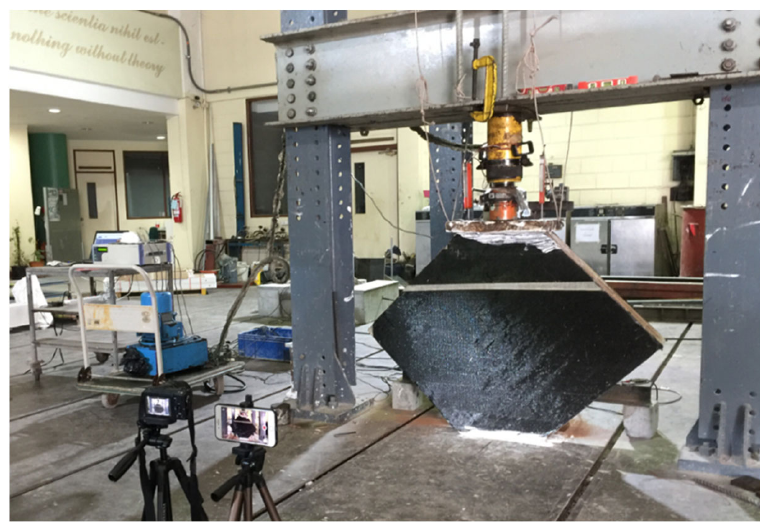
Figure 5. Sketch of loading setup (units are in mm).